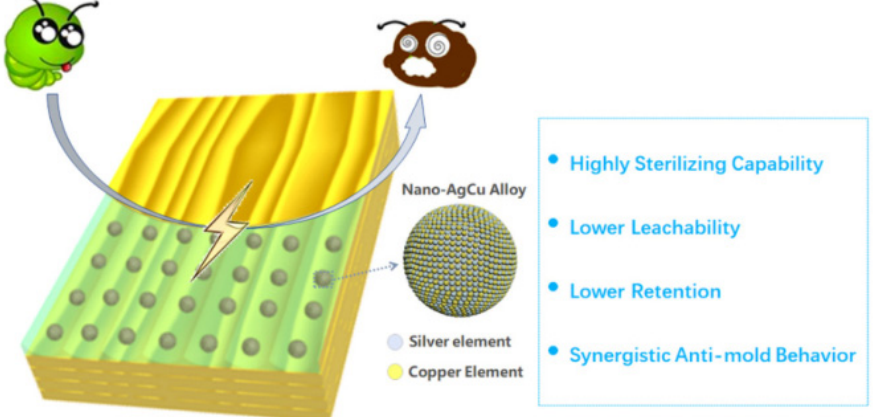
Figure 11. Schematic illustration of the nano silver-copper alloy (nano-AgCu) for mold resistance on the surface of wood [100].